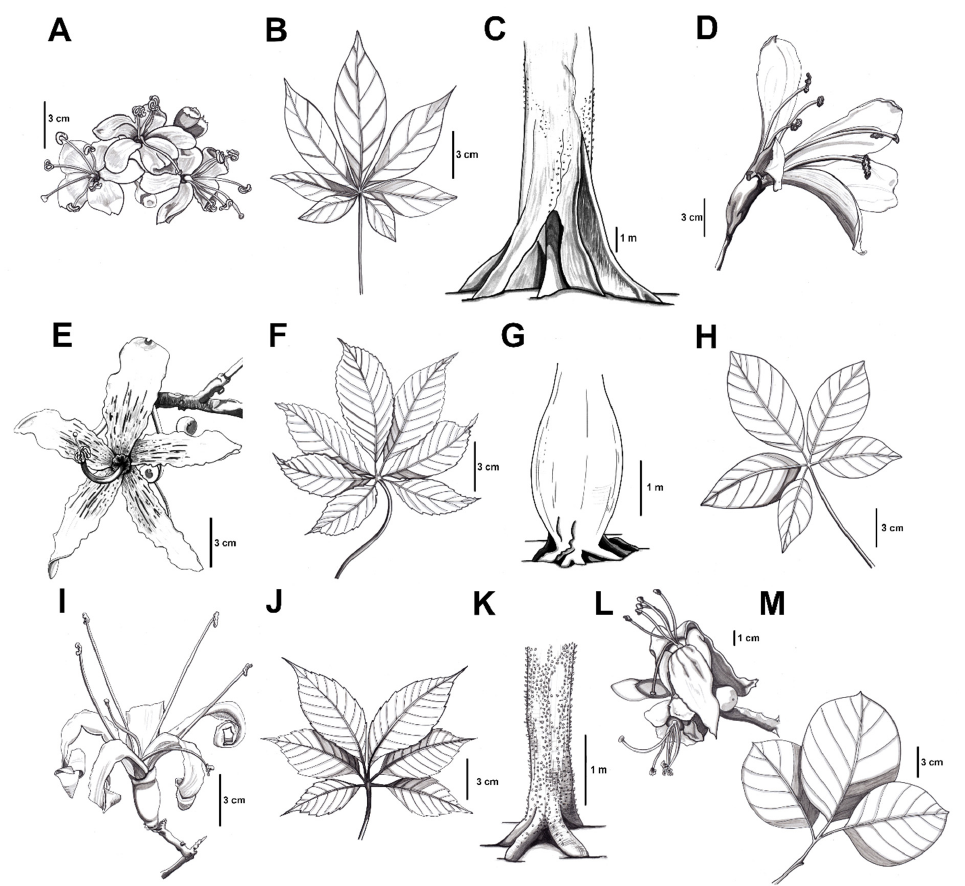
Figure 2. Representative illustrations of the diversity of flowers, leaves and trunks seen within the genus Ceiba . ( A – C ): C. pentandra ; ( D , H ): C. samauma ; ( E – G ): C. speciosa ; ( I – K ): C. aesculifolia ; ( L , M ): C. jasminodora